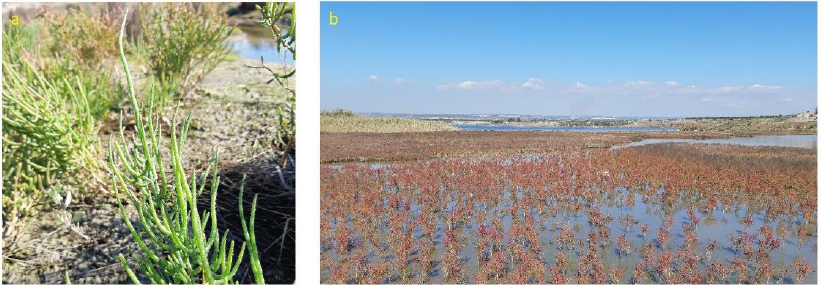
Figure 3. Salicornia dolichostachya ( a ); a plant community dominated by S. dolichostachya and S. emerici ( b ) at “Palude La Vela”, Taranto, southern Apulia).